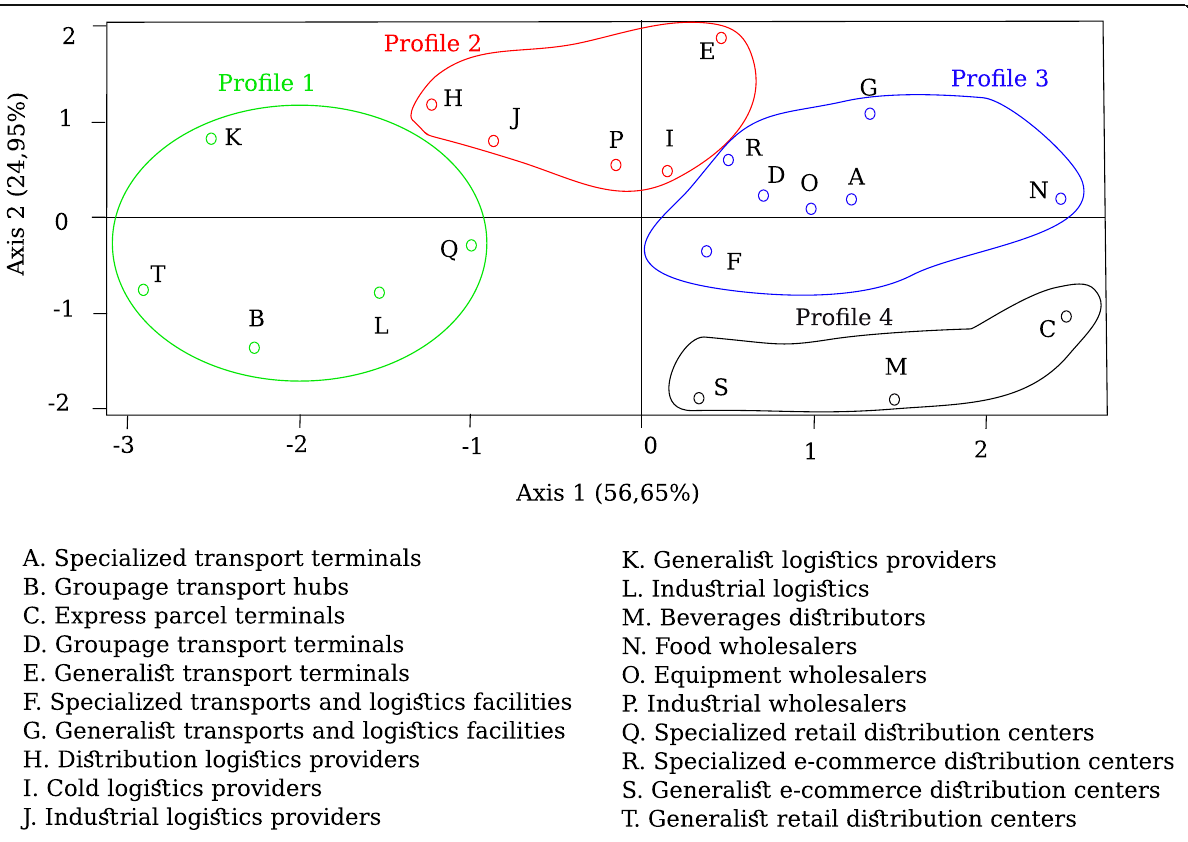
Fig. 7 Clusters of logistics sectors (on PCA ’ s coordinates of first factorial